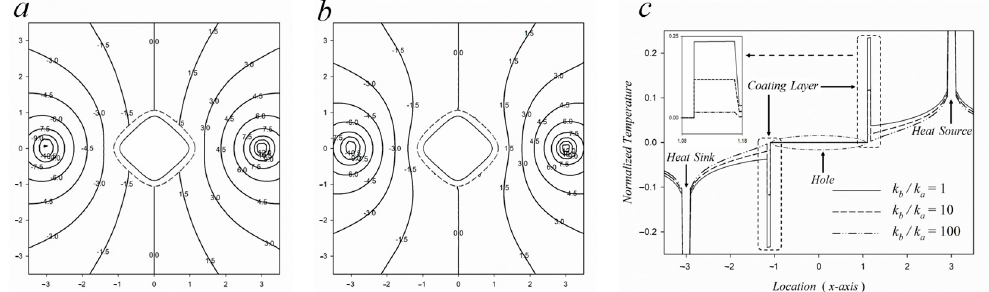
Figure 6. Contours of temperature distribution for a coated equiangular square hole, where ( a ) k b /k a = 10 and ( b ) k b /k a = 100. ( c ) Quantitatively normalized temperature for a coated triangular hole with different ratios of heat conductivity, where w = 0.1.